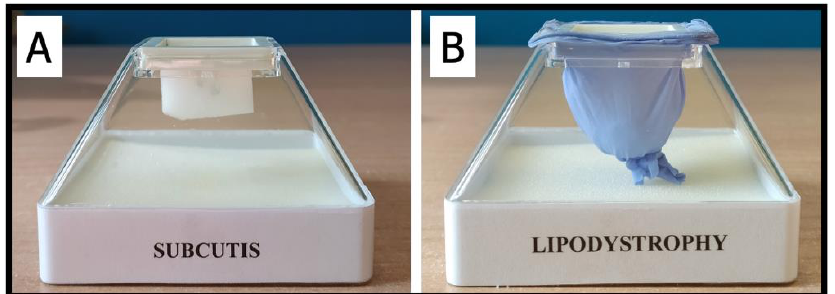
Figure 2. Representation of the pyramid was used to raise participants’ awareness of what happens at the injection site. ( A ) The use of a piece of gauze simulated the subcutis. ( B ) With the use of a piece of glove and cotton, lipodystrophy was simulated.